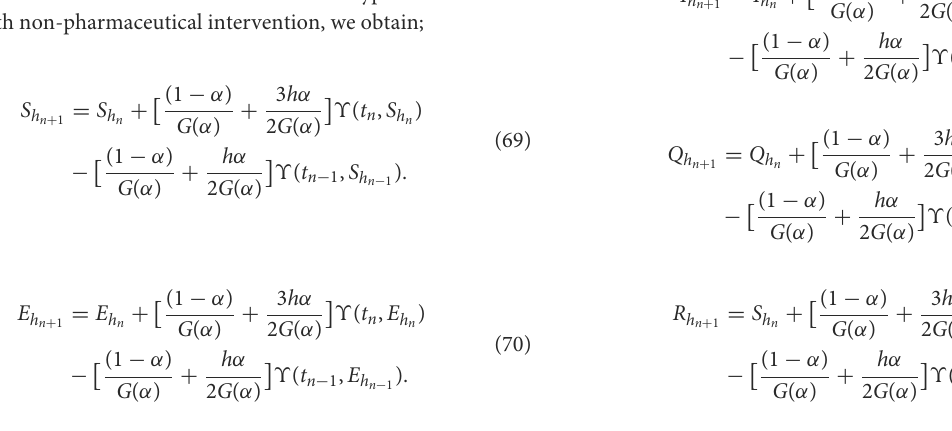
Thus, in terms of our CF-fractional monkeypox transmission model with non-pharmaceutical intervention, we